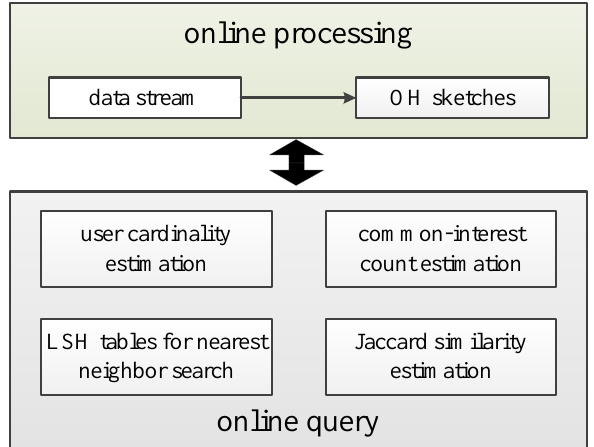
Figure 1. Framework of our framework